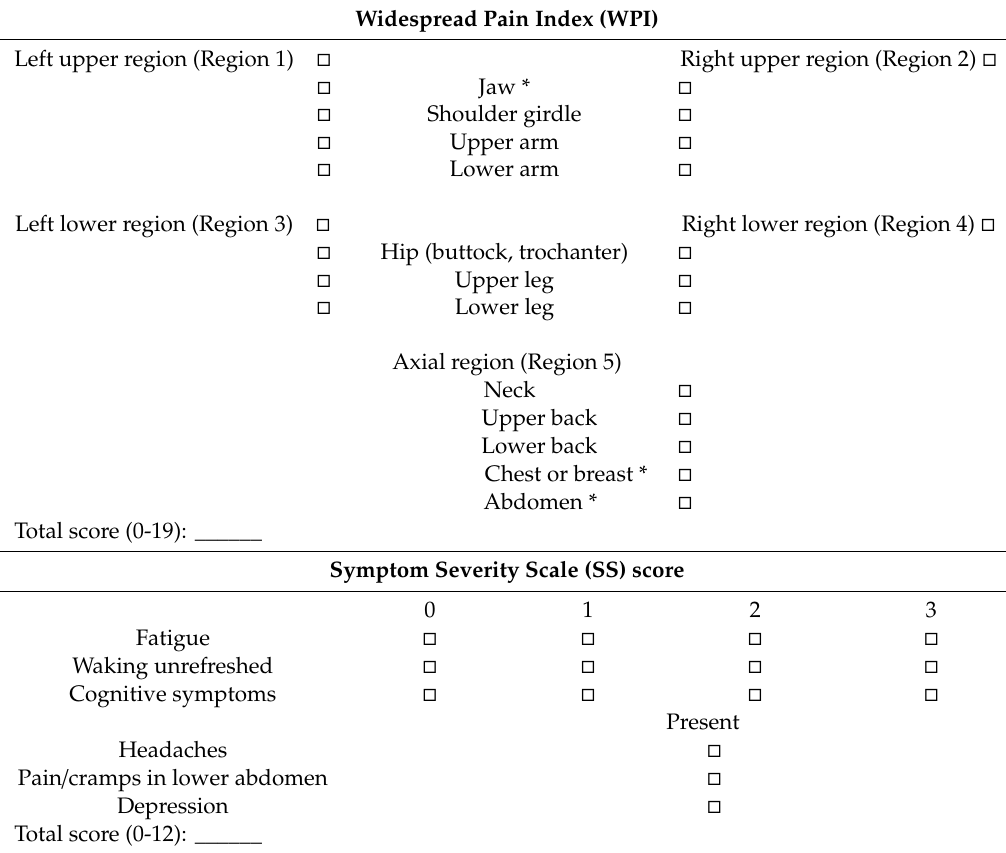
Table 1. Fibromyalgia diagnostic criteria—2016